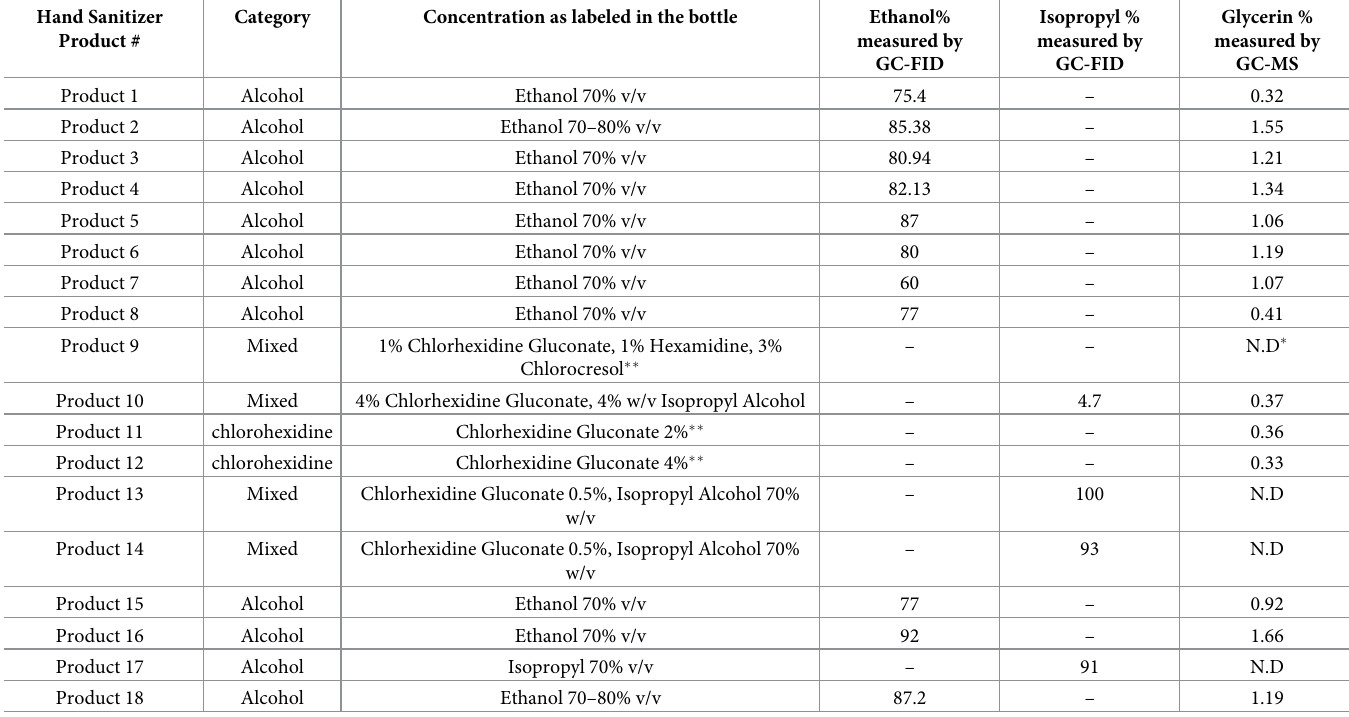
Table 1. This table lists the 18 disinfectant products collected from the local market of Riyadh, Saudi